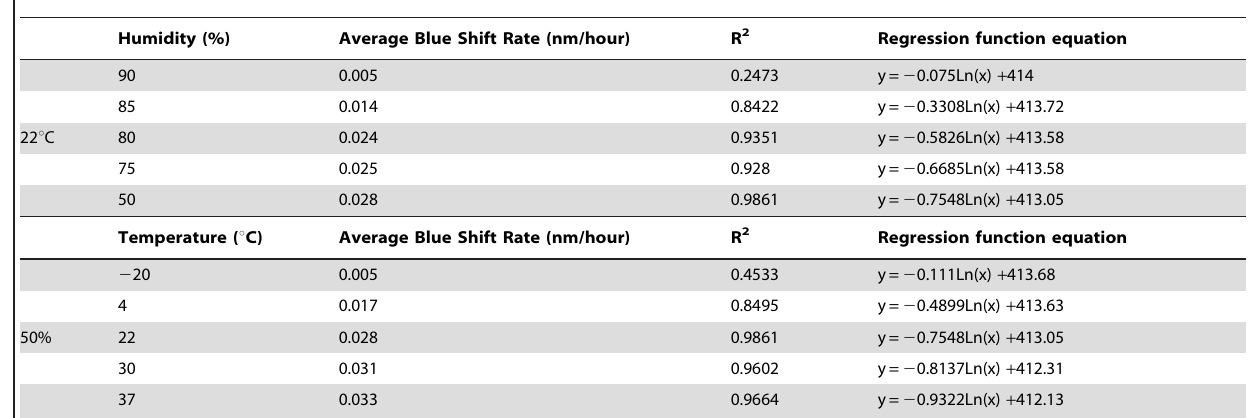
Table 1. Effects of Temperature and Humidity on the Soret Band Blue Shift.